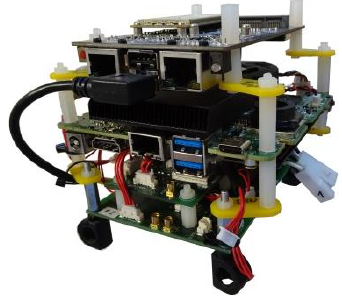
Figure 3: Nav-Com-Stack